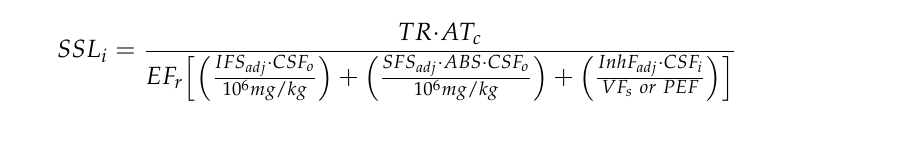
Table 2. Exposure parameters for carcinogenic risk